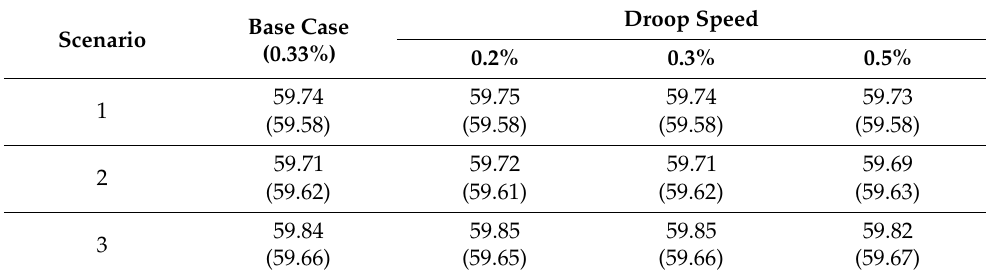
Table 10. Lowest frequency per parameter (droop control) (Hz): three-phase short